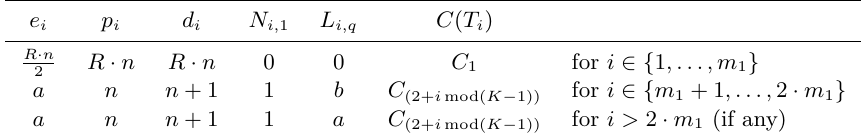
Table 2 Parameters of the tasks in τ seq ( n, m 1 , R ), where a = 1 and b = 2 if m 1 > 1, and a = 1 b = 1 if m 1 = 1. Tasks T 1 , . . . , T m are assigned to the first cluster C 1 ; all other tasks are assigned in a 1 round-robin fashion to clusters other than C 1 . Recall that n ≥ m ≥ 2 · m 1 .